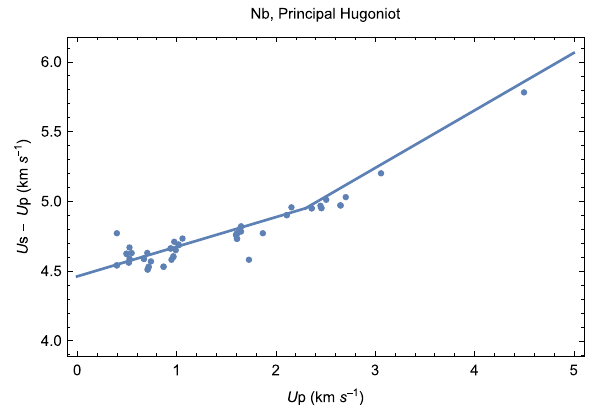
Fig. 9 The difference of shock ( U s ) and particle ( U p ) velocities as a function of U p along the Nb Hugoniot. The two straight segments are the Hugoniots of body-centered cubic bcc-Nb (the lower one) and orthorhombic Pnma -Nb (the upper one) described by U s − U p = a + ( b − 1) U a , b ) parameters. p with the corresponding sets of (